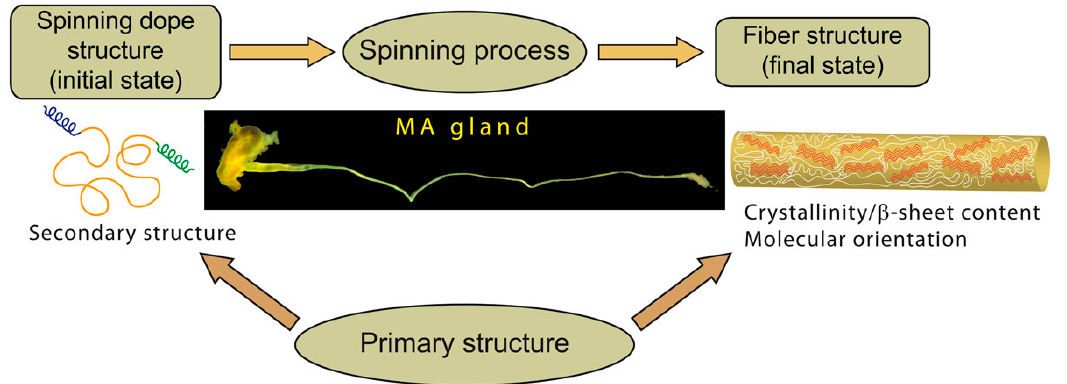
Figure 1. Schematics showing the relationships between the structure of major ampullate (MA) spidroins in the silk dope, the fiber structure, the spinning process and the primary structure. Silk formation corresponds to the transformation converting the spidroins in the dope (initial conformational state) into the silk fiber (final structural state). The spinning process (mechanical constraints applied, physicochemical environment) and primary structure (chemical composition) are the two factors that govern structural changes. On one hand, the spinning process triggers and induces conformational and orientational changes to the polypeptide chains. On the other hand, the response of spidroins and the final secondary structure they adopt are dictated by the sequence.